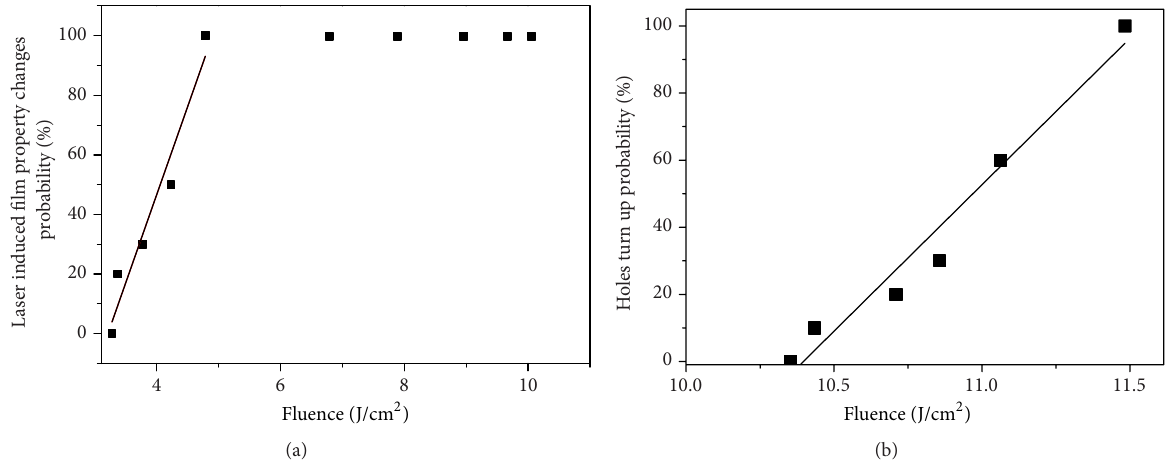
Figure 5: Damage test results for FEP film: (a) property changes probability (second process) and (b) holes turn up probability (third